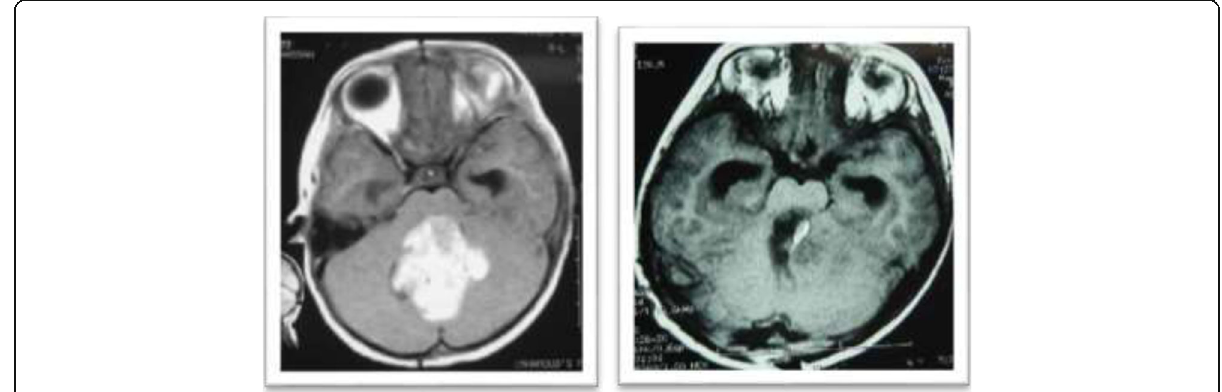
Fig. 2 (Left) Pre-op MRI brain axial cut show fourth ventricular mass with homogenous enhancement and hydrocephalus operated via the transvermian approach. (Right) Immediate postoperative MRI brain axial view with contrast shows no residual, no